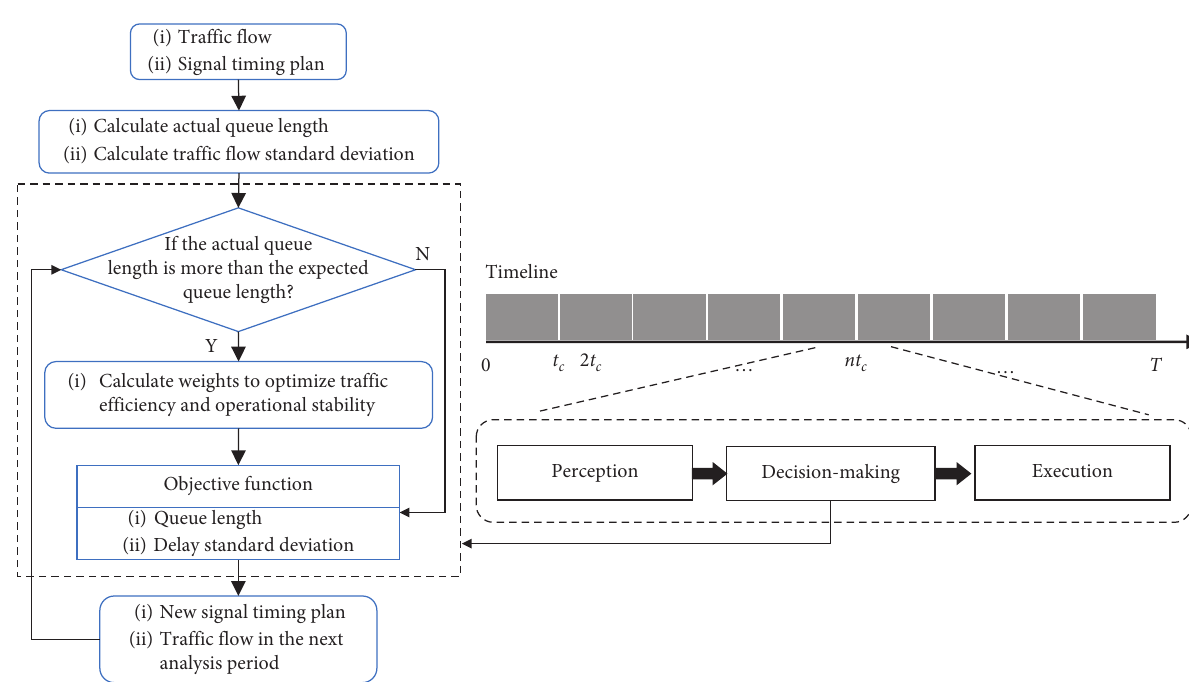
Figure 2: The flowchart of the dynamic control